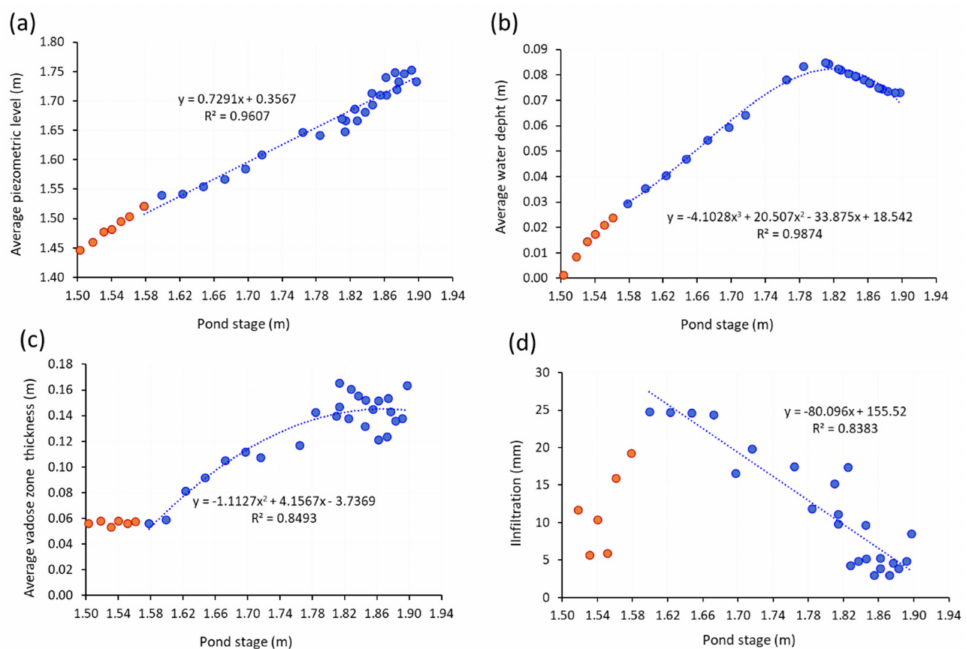
Figure 11. Relationship between variables that condition the rate of infiltration from the pond to the aquifer. ( a ) shows the evolution of the pond stage with the average piezometric level, ( b ) the evolution of the pond stage with the average water depth, ( c ) the evolution of the pond stage with the average thickness of the vadose zone and ( d ) the evolution of the pond stage with infiltration The orange points correspond to the pond stage at the pond ´ s central